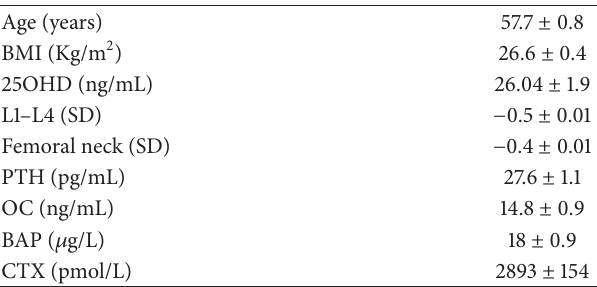
Table 1: Clinical and biochemical features and 𝑇 -scores of studied population. Data are mean ± standard error.